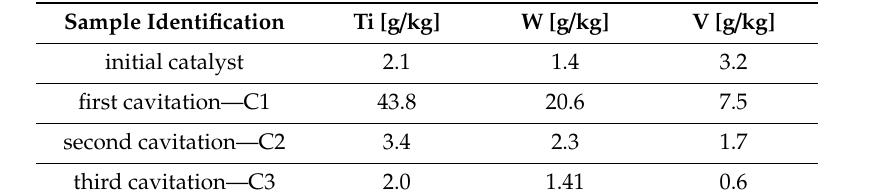
Table 1. Metal concentration of the solid fraction in the initial and after the first (C1), second (C2), and third (C3) cavitation.